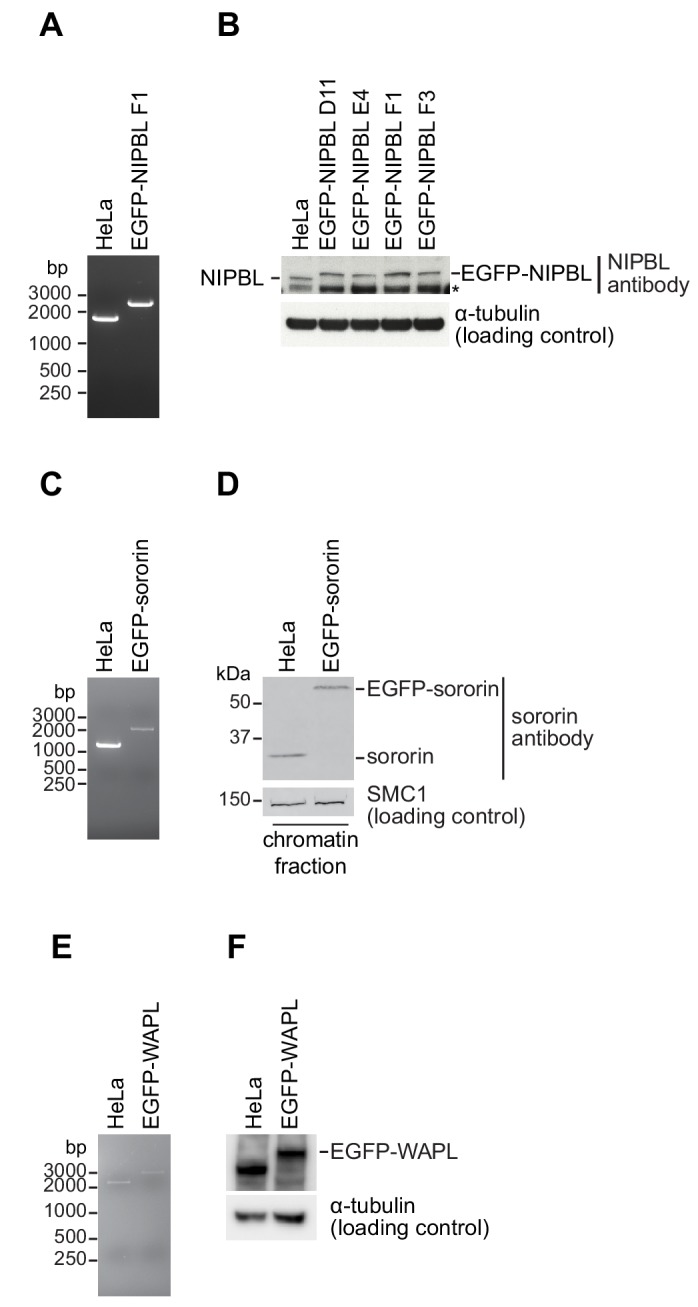
Cell line characterisation.(A, C, E) PCR genotype analysis of parental and homozygous EGFP tagged HeLa cells used in this study. PCR primers annealed external to the homology arm that was used to insert EGFP in each cell line; a single larger PCR product in the tagged cell line relative to the parental cell line was consistent with homozygosity. (B) Immunoblotting analysis of whole-cell extracts from parental HeLa cells and four homozygously tagged EGFP-NIPBL HeLa cell lines. Clone F1 was used for all experiments. α-tubulin was used as a loading control. Asterisk denotes non-specific signal. (D) Immunoblotting analysis of chromatin extracts from parental HeLa cells and EGFP-sororin tagged HeLa cells. SMC1 was used as a loading control. Note that the EGFP-sororin cell line displayed a mitotic defect, raising the possibility that EGFP-sororin may be hypomorphic. (F) Immunoblotting analysis of whole-cell extracts from parental HeLa cells and EGFP-WAPL tagged HeLa cell line. α-tubulin was used as a loading control. Characterisation of the EGFP-STAG1, STAG1-EGFP and STAG2-EGFP cell lines will be published elsewhere. Characterisation of the SCC1-mEGFP and CTCF-EGFP cell lines was previously published (Davidson et al., 2016; Wutz et al., 2017).